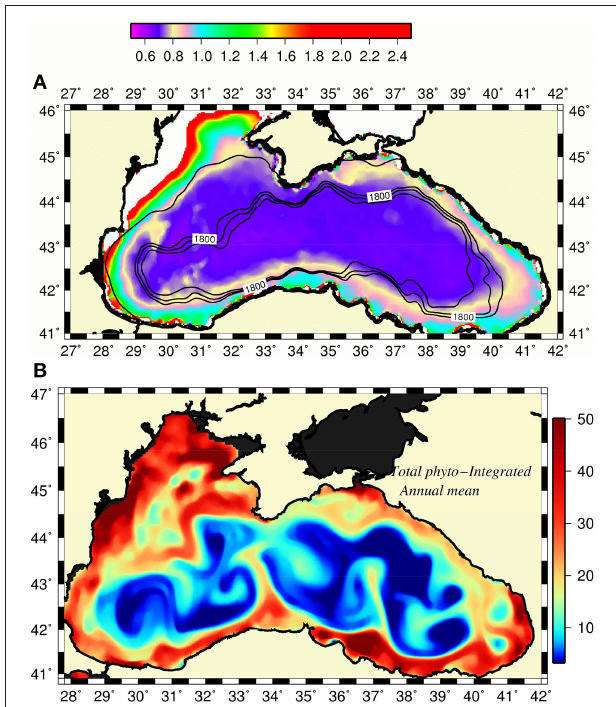
FIGURE 6 | (A) Long-term (2002–2015) mean surface chlorophyll a concentration distribution (mg Chl m − 3 ) with the margin topography superimposed by 1,800, 2,000, and 2,200m isobaths, (B) annual-mean euphotic-layer integrated phytoplankton biomass distribution (mmol N m − 2 ) provided by model simulations. The narrow strip of white color along the western coast designates chlorophyll concentration greater than 2.5mg m − 3